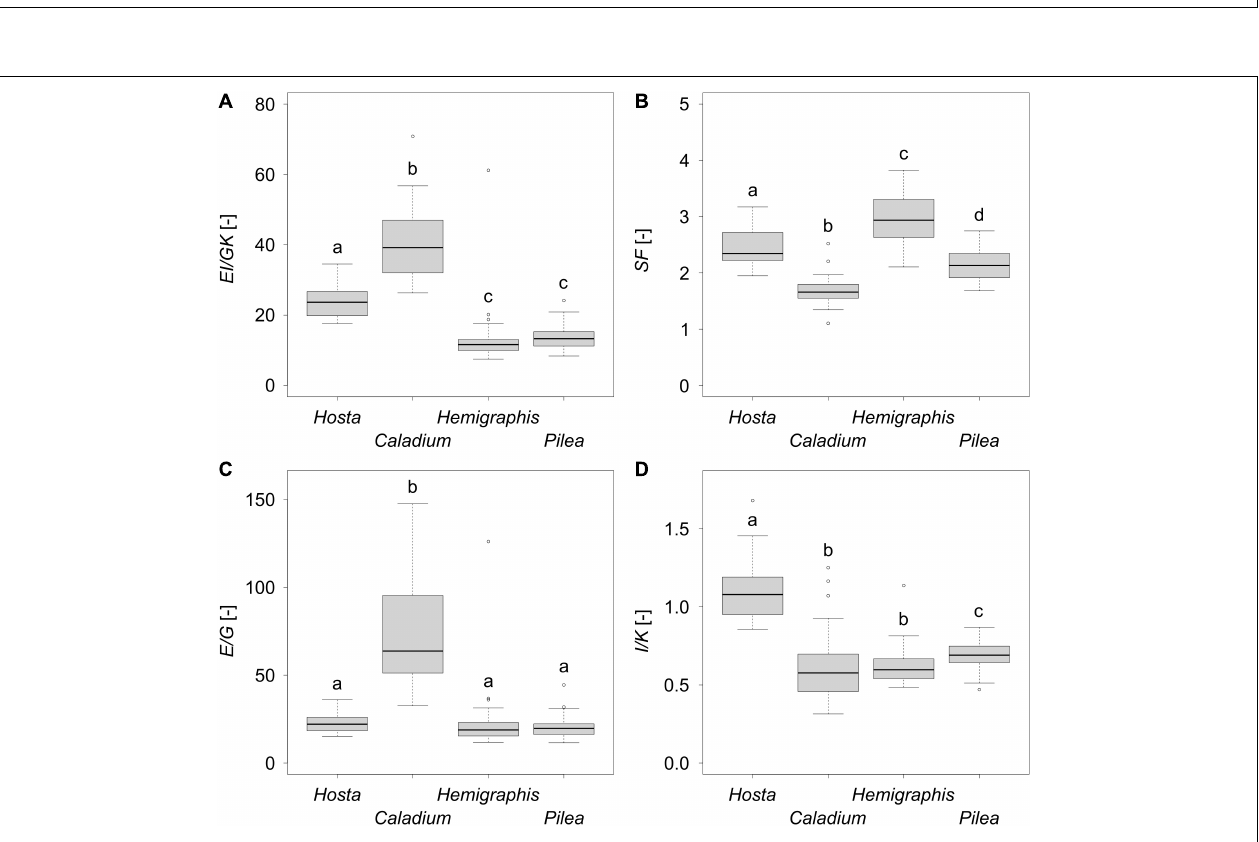
FIGURE 5 | Boxplots of (A) the twist-to-bend ratio EI/GK , (B) the safety factor SF , (C) the ratio of the elastic to the torsional modulus E/G, and (D) the ratio of the axial second moment of area to the torsion constant I/K of 25 leaves each of the species Hosta x tardiana ‘El Niño’, Caladium bicolor , Hemigraphis alternata, and Pilea peperomioides . Significant differences ( p -value < 0.05) are indicated by lower case letters.